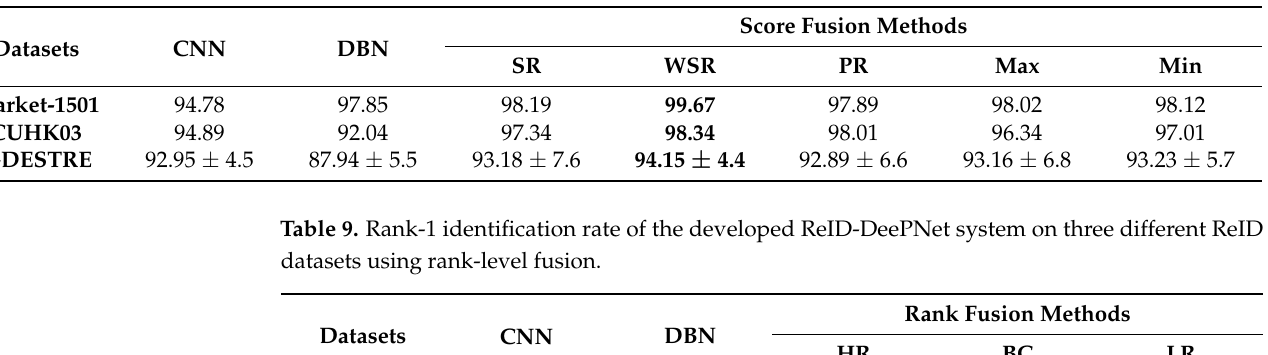
Table 8. mAP of the developed ReID-DeePNet system on three different ReID datasets using score- level fusion.